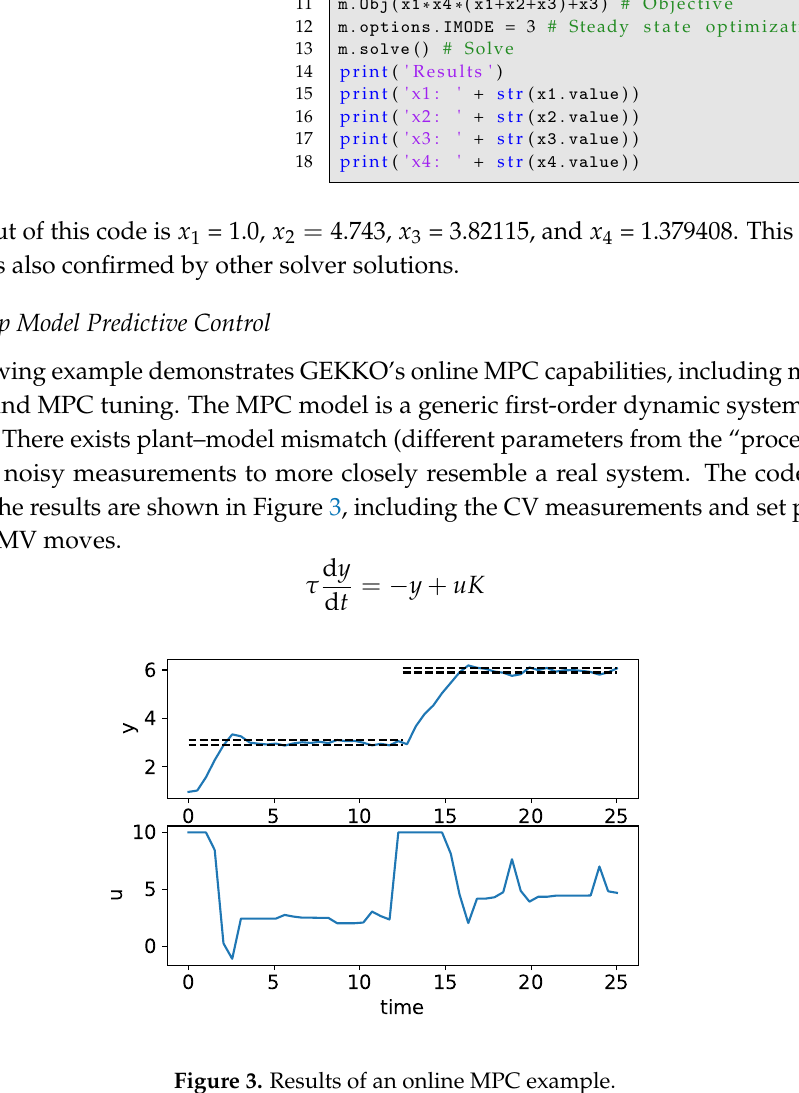
Figure 3. Results of an online MPC